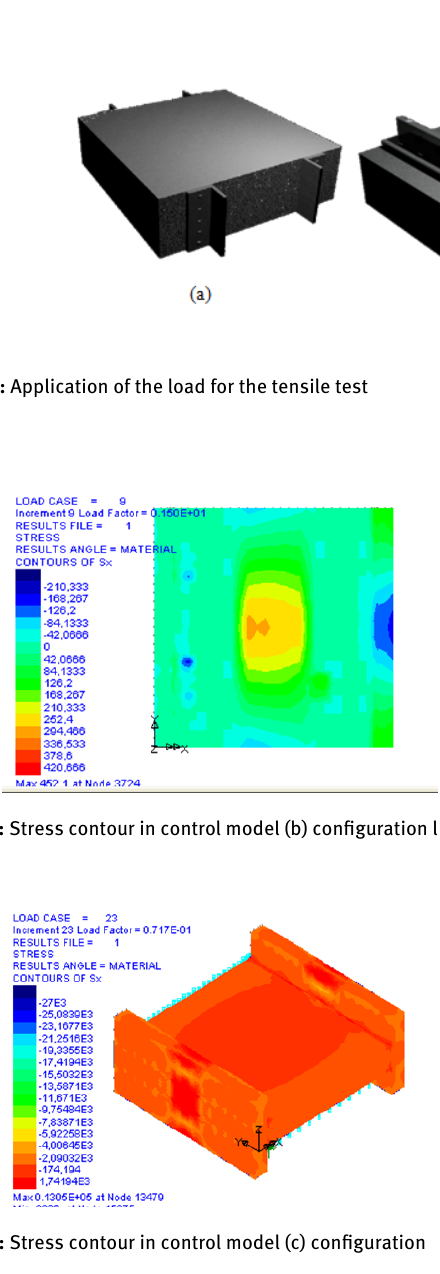
Figure 22: FE simulation of the flexural test Figure 23: Numerical and experimental comparison in bending